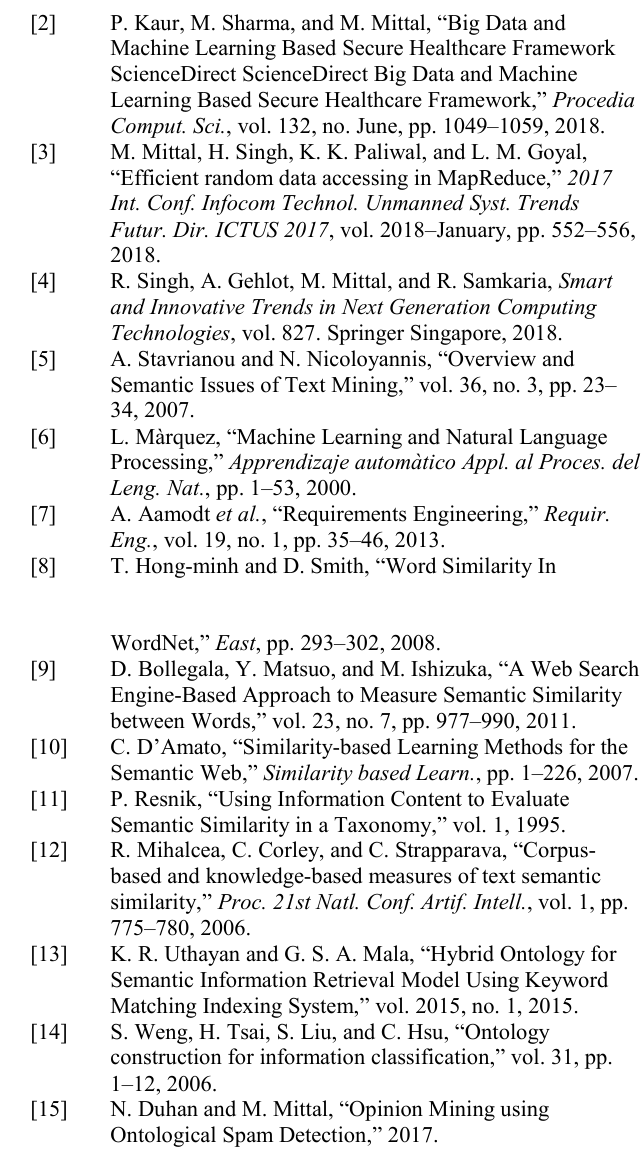
Figure 8 Represention of taxinomical relationships among the